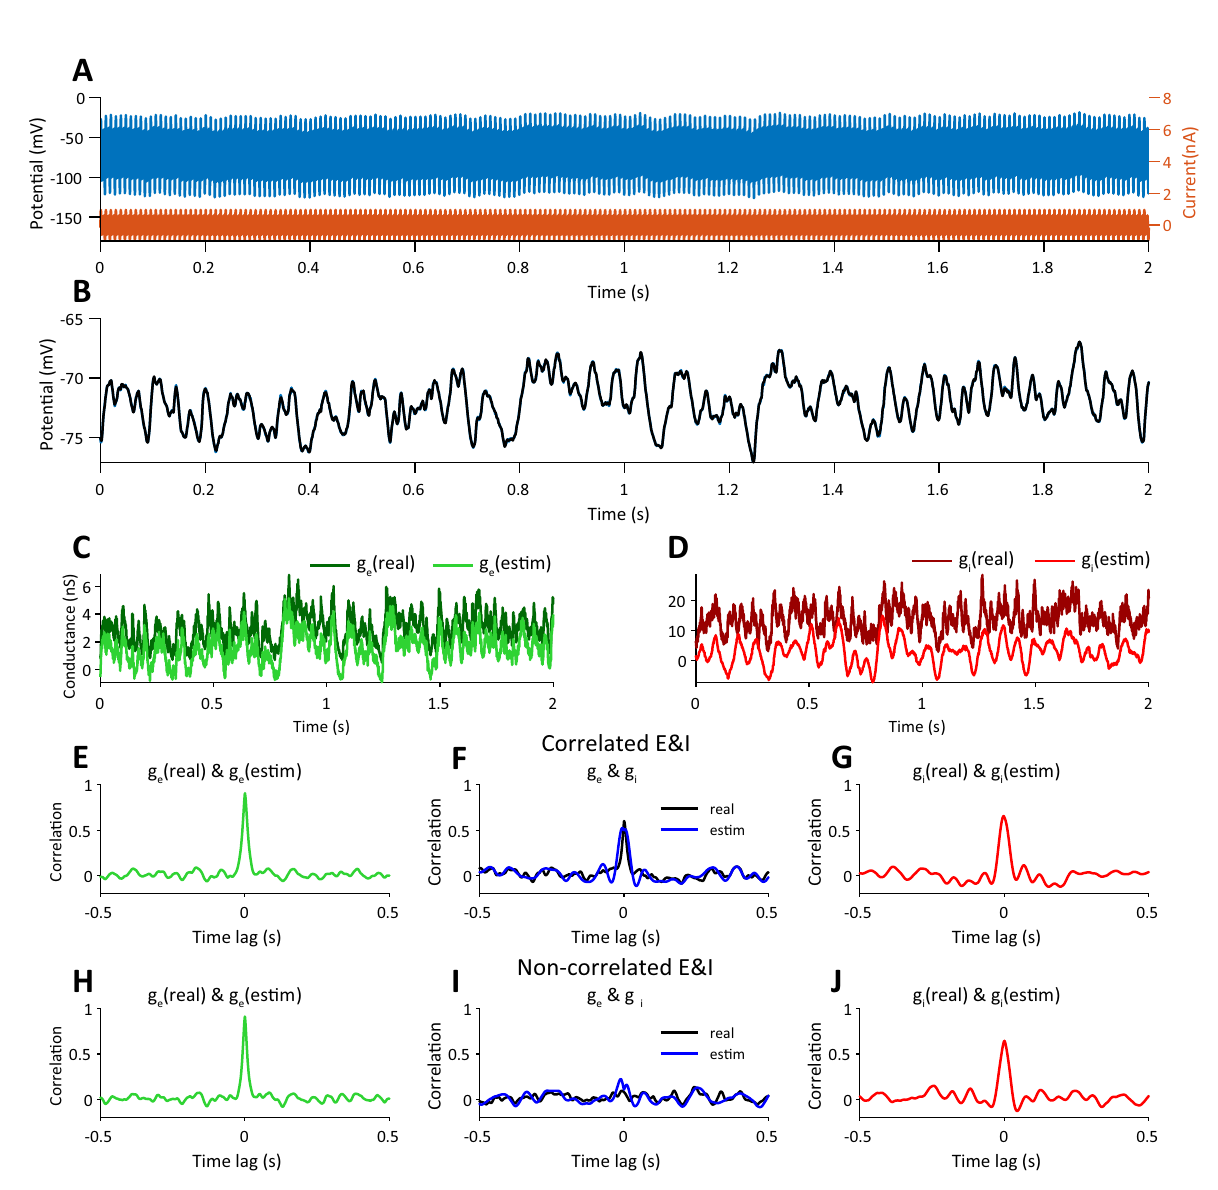
Fig 5. Estimation of the correlation between excitatory and inhibitory conductances of a neuron embedded in balanced/unbalanced Networks. A. Excitatory and inhibitory conductances taken from network simulations (see text) were used to simulate the response of a point neuron recorded with a 50M Ω pipette while injected with 210Hz & 315Hz 0.5 nA sinusoidal current. B. The voltage in A was ‘cleaned’ from the sinusoidal component (black trace) and it is displayed with the voltage response of the cell when no current was injected superimposed with the ‘cleaned’ voltage. C-D. Estimated excitatory and inhibitory conductances superimposed with the imposed conductances of the simulated cell. E, G. Color lines describe the cross- correlations between the imposed and estimated excitatory and inhibitory conductances for the balanced cortical Dynamics. F. The correlations between measured g and g (blue line) and between the imposed g and g (black line). H-J. The same analysis as for e-g but after shifting the inhibitory input by 10 e i e i seconds to mimic uncorrelated excitatory and inhibitory